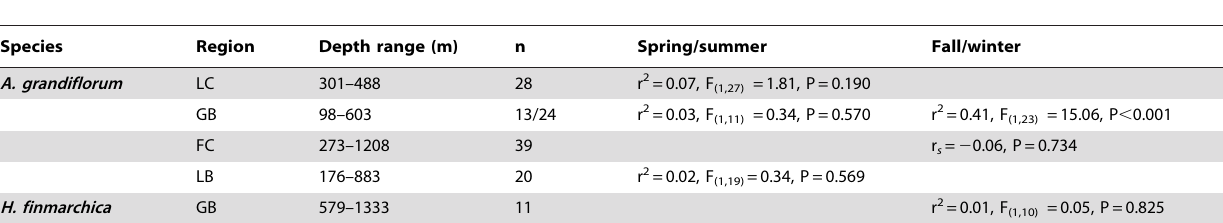
Table 3. Influence of increasing depth on total mean yield (MEYtot) of all associates on colonies of Anthoptilum grandiflorum and Halipteris finmarchica in the different geographic regions (only sites with more than 10 colonies harbouring associated species were